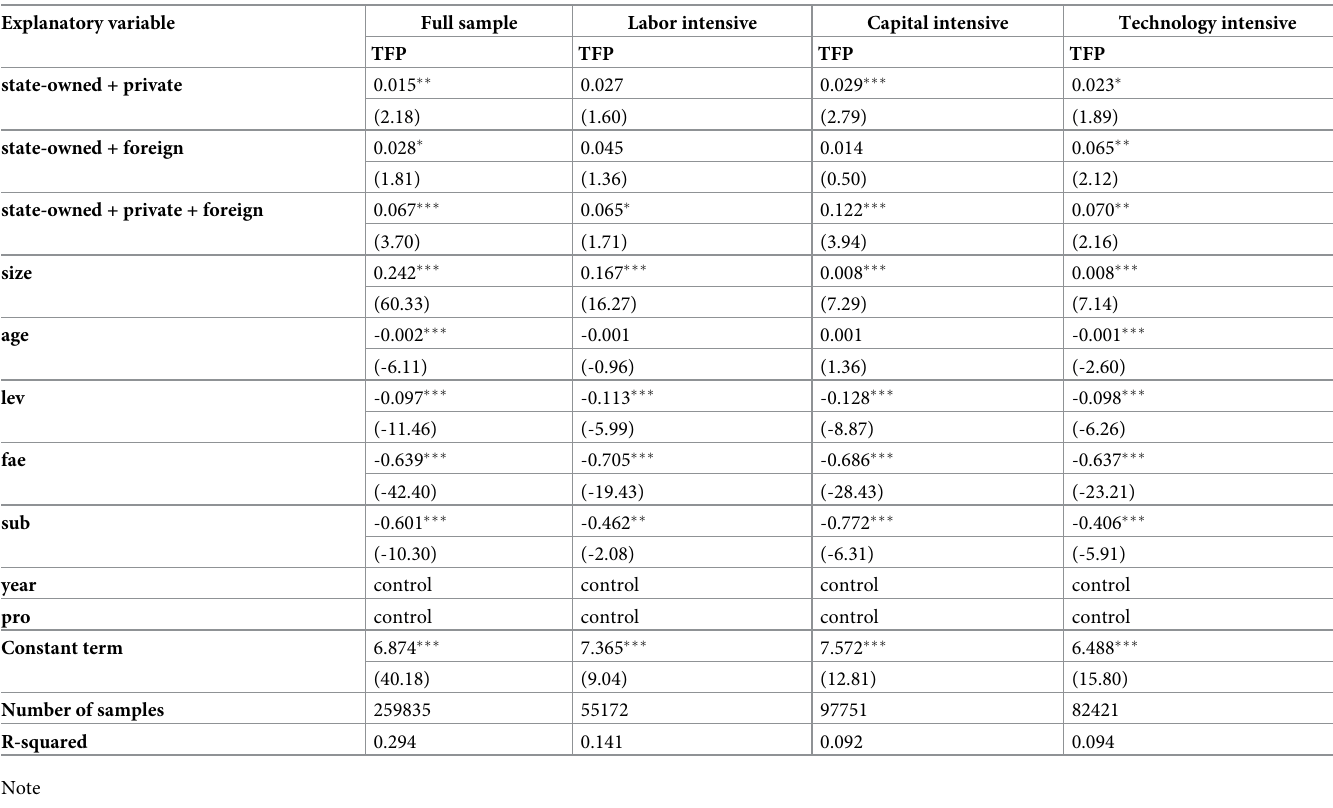
Table 3. The regression results of ownership structure on enterprise